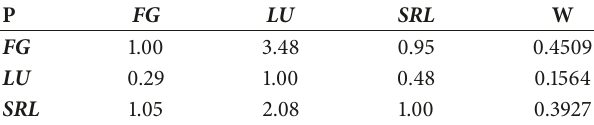
Table 11: Comparison for highway classification node.